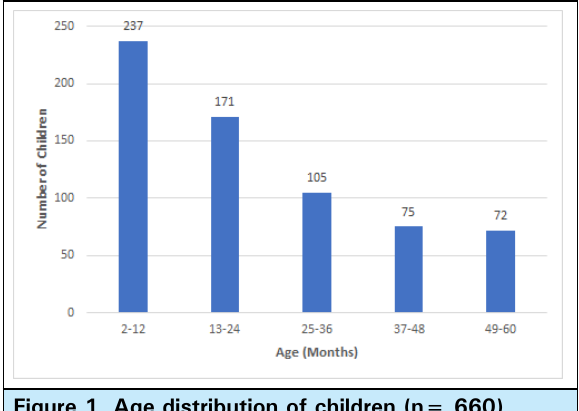
Figure 1. Age distribution of children (n=